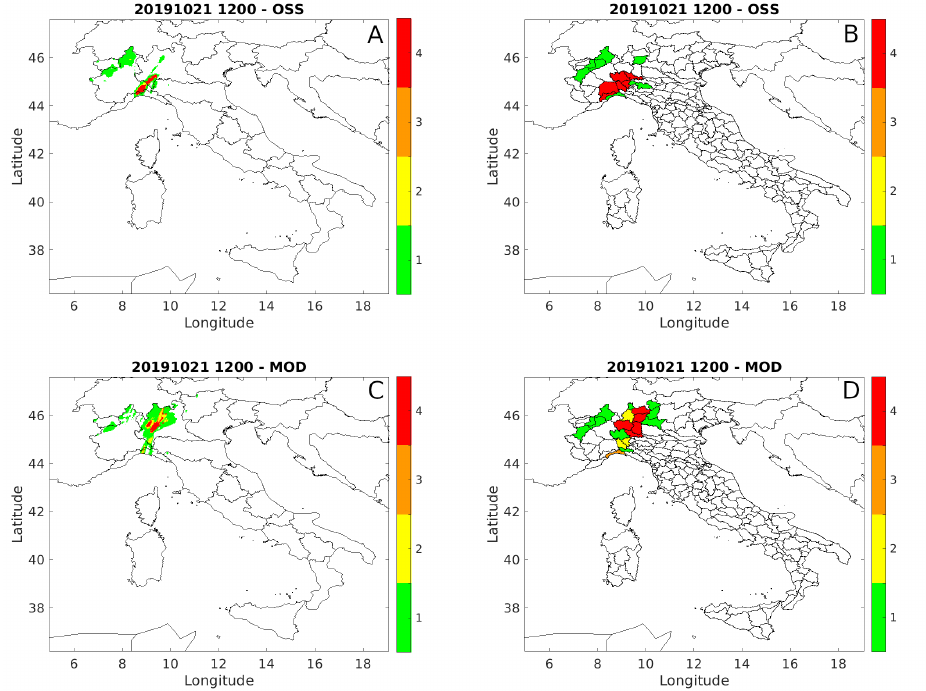
Figure 13. Scenario generated for the 21 October 2019 event at 12 UTC for the next 6 h. Panels ( A , B ) refer to observed scenario, panels ( C , D ) to the modeled